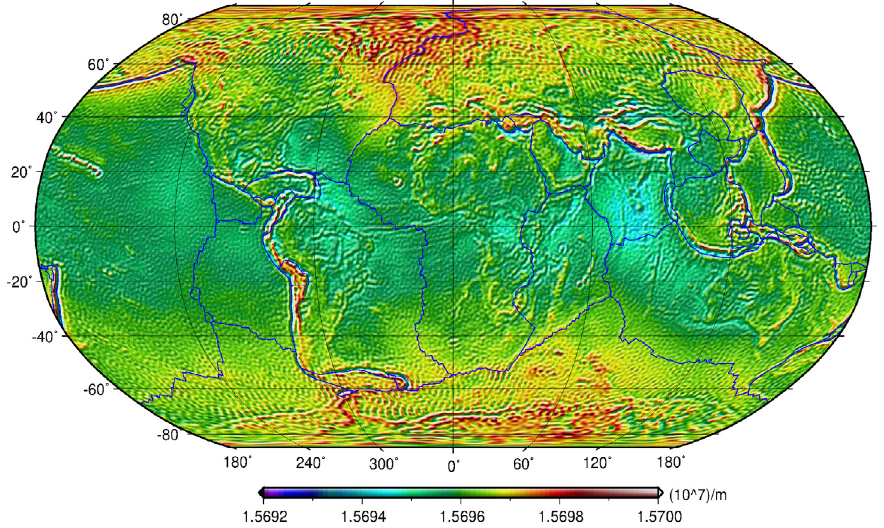
Figure 2. Mean curvature [10 -7 /m] of the NULP-02S level surface V = const ( ––– basic plates boundaries).